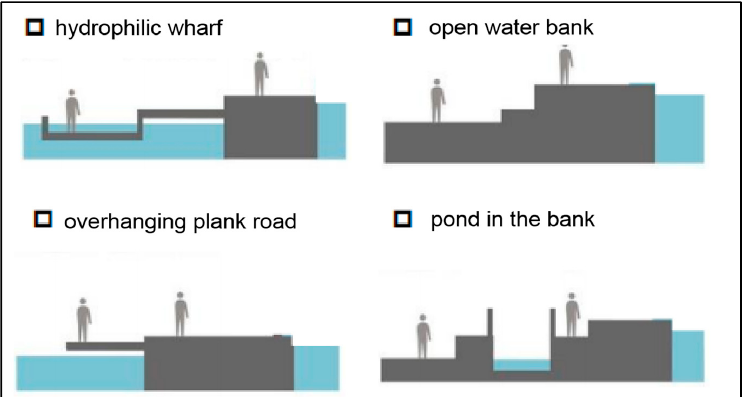
Figure 7. Changes of shoreline design in Heshu village.